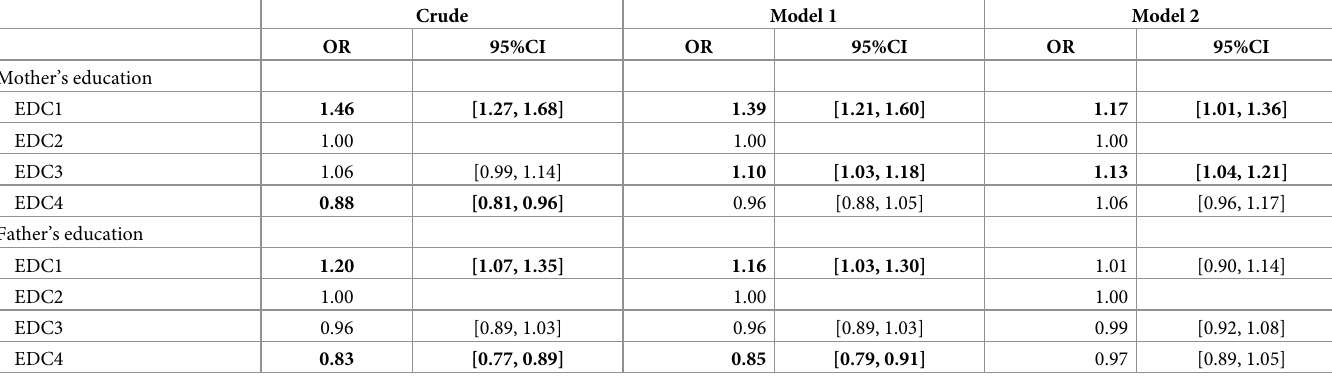
Table 3. Crude and adjusted odds ratios for doctor-diagnosed asthma in multilevel logistic regression analysis (multiple imputation, N = 69,067).